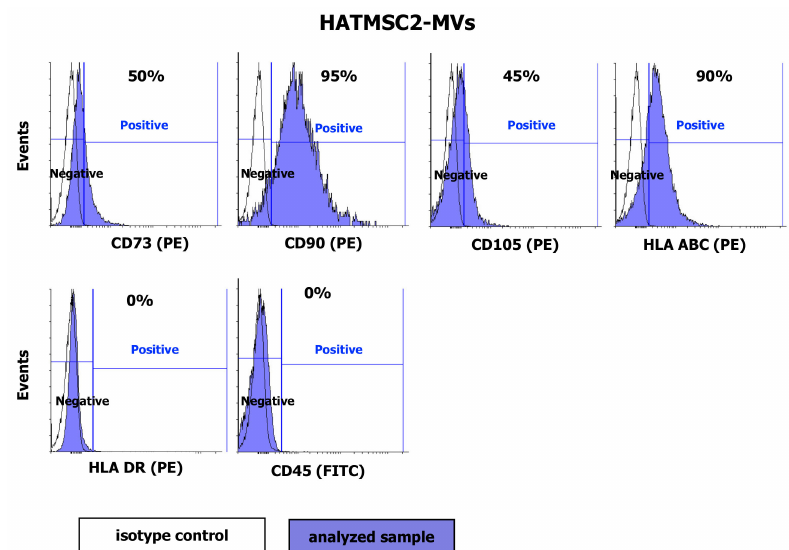
Figure 2. Representative flow cytometry histograms of flow cytometry analysis of mesenchymal stem cells markers (CD73, CD90, CD105, HLA ABC, HLA DR, and CD45) on HATMSC2 cells and HATMSC2-MVs from three independent experiments. Cells and MVs were stained with selected antibodies conjugated with fluorochromes. Blue filled histograms correspond to HATMSC2 cells and HATMSC2-MVs labeled with defined antibodies, and empty histograms represent the isotype controls. HATMSC2-MVs—microvesicles derived from immortalized human mesenchymal stem cells of adipose tissue origin.